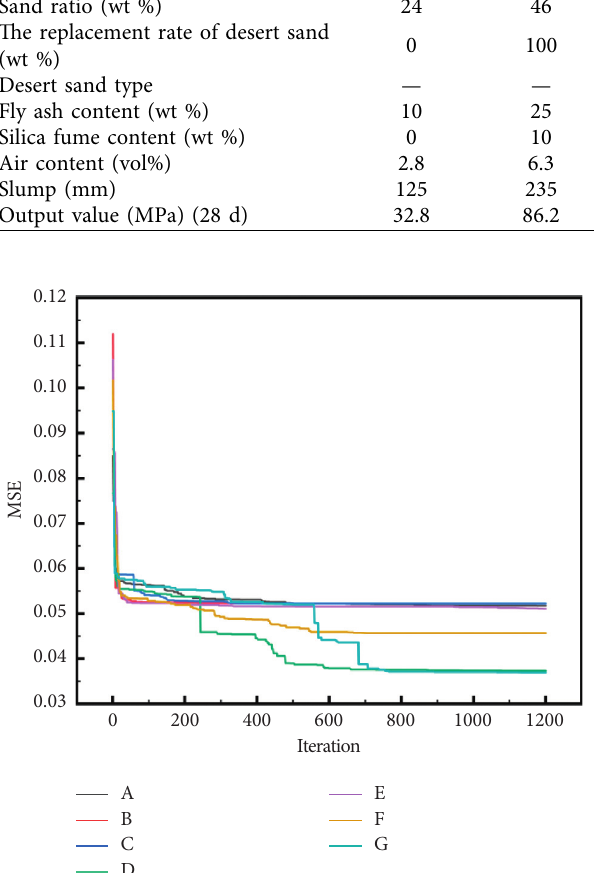
Figure 3: Selection of modeling parameter schemes.